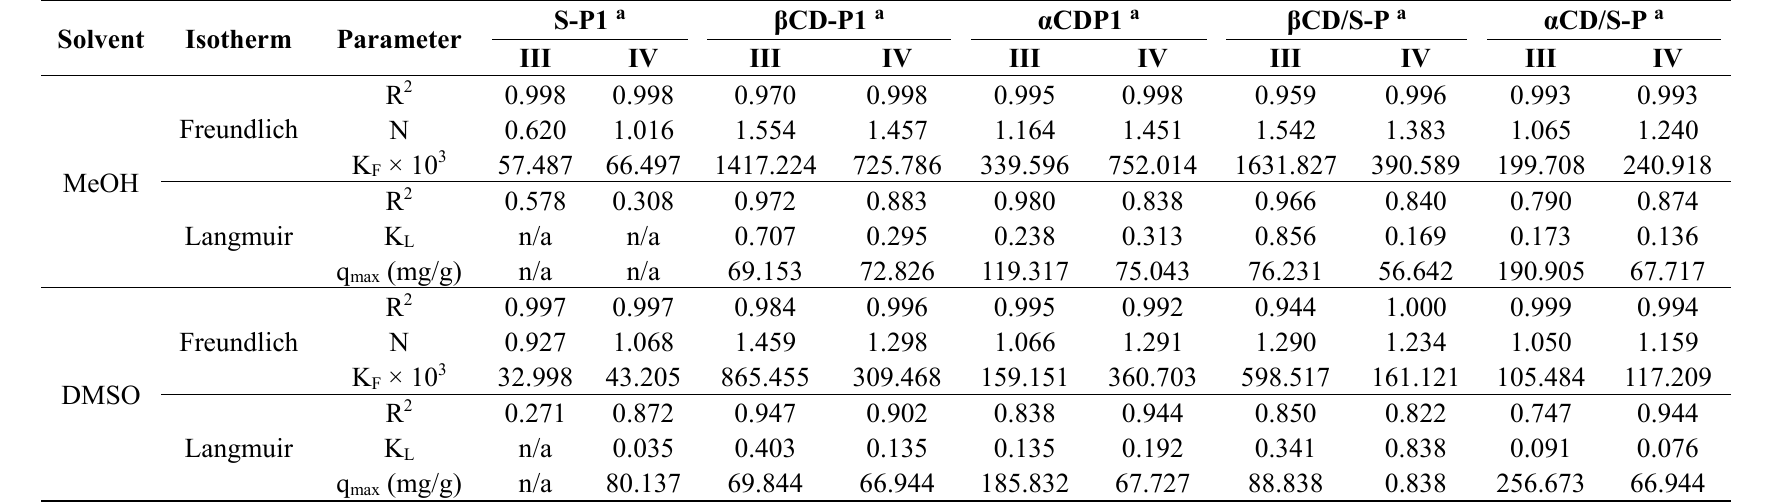
Table 4. Freundlich and Langmuir parameters for the sorption of bisphenol A ( III ) and β -naphthol ( IV ) (20–1000 ppm solutions in water and either 10% methanol or 10% DMSO) on the DVS cross-linked homo- ( S-Pn and CD-Pn ) a and hetero-polymers ( CDS/S-P1 ) (1:1